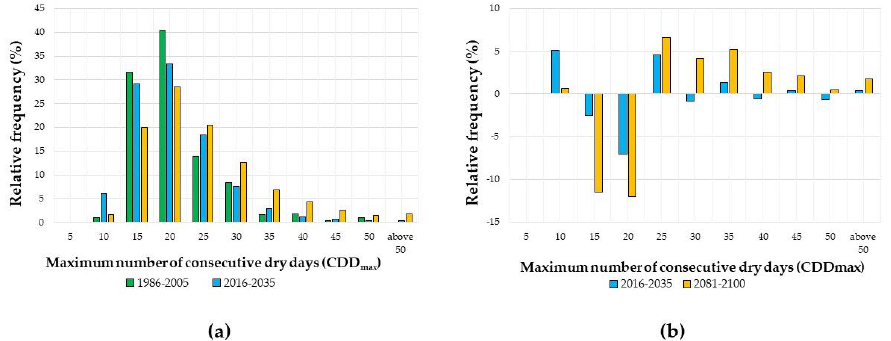
Figure 4. Frequency distribution of the maximum number of consecutive dry days (CDD max ) in Hungary during the growing season in the three investigated periods ( a ) and changes of these frequencies from the 1986 – 2005 reference period to the near (2016 – 2035) and distant (2081 – 2100) future periods ( b ).